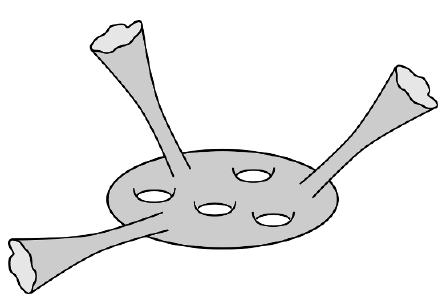
Figure 1 . A cartoon of the geometry that computes Z g ( (cid:12) 1 ; r 1 ; : : : ; (cid:12) n ; r n ). There is a genus g surface glued to n \trumpets" associated to the insertions of Tr H boundary conditions at the ends of the trumpets are determined by (cid:12) and r